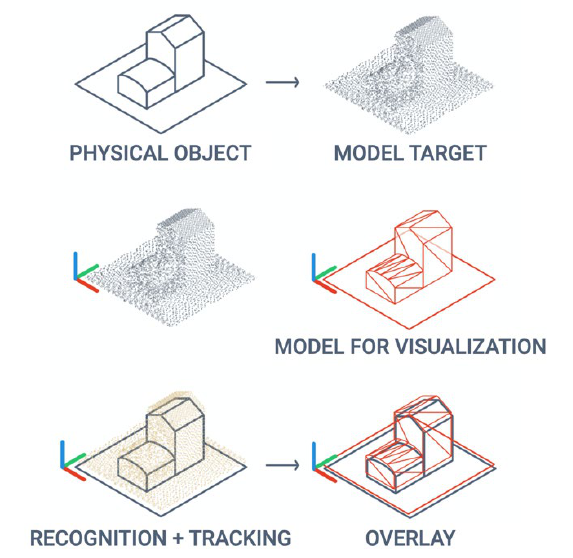
Figure 6. Scheme of the markerless AR tracking